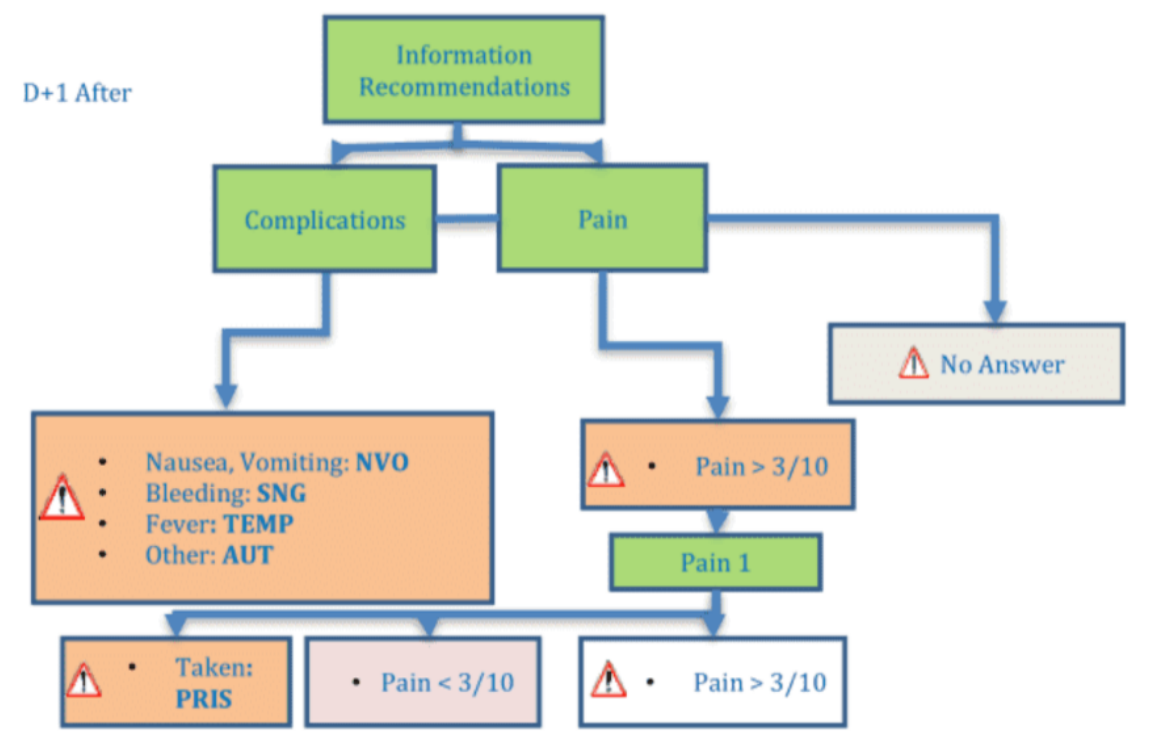
Figure 3. Short message service text pattern day 1 after surgery.